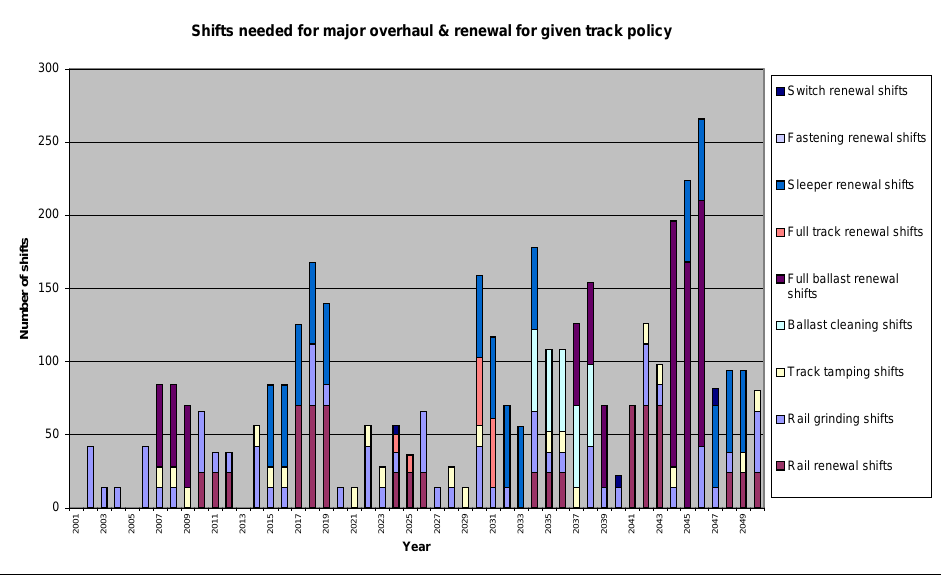
Figure 4. Planned work shifts, intermediate result after step